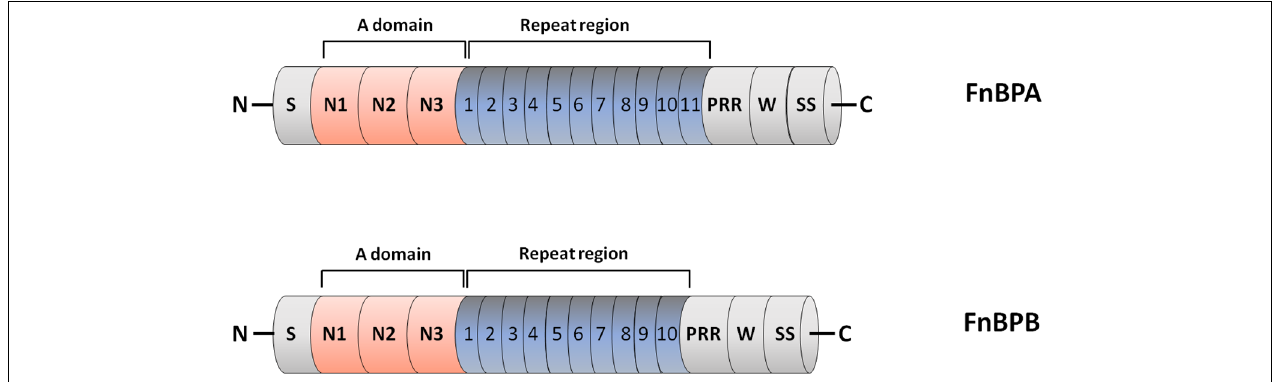
FIGURE 1 | Domain organization of fibronectin-binding protein A and B (FnBPA and FnBPB). The primary translation products of FnBPA and FnBPB proteins contain a signal sequence (S) at the N-terminus and a sorting signal (SS) at the C-terminus. The N-terminal A region of both proteins contains three separately folded subdomains, termed N1, N2 and N3. N2 and N3 form IgG-like folds that combined bind ligands such as fibrinogen by the DLL mechanism. Located distal to the A domain is an unstructured region consisting of tandemly arranged motifs (11 in FnBPA and 10 in FnBPB) that individually bind to the N-terminal domain of fibronectin. Also shown are the locations of proline rich region (PRR) and wall spanning region (W).